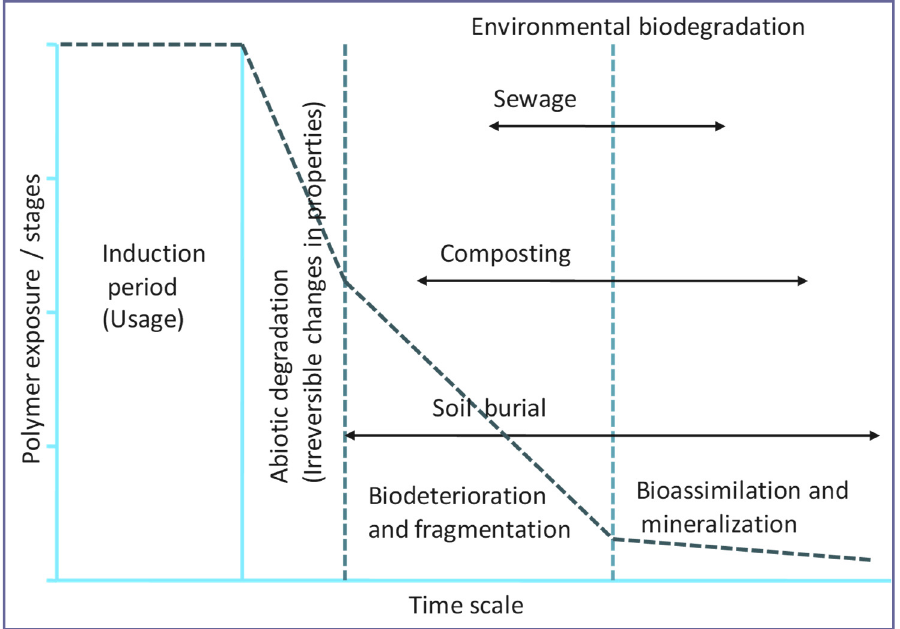
Figure 2. Environmental biodegradation steps of the polymer.